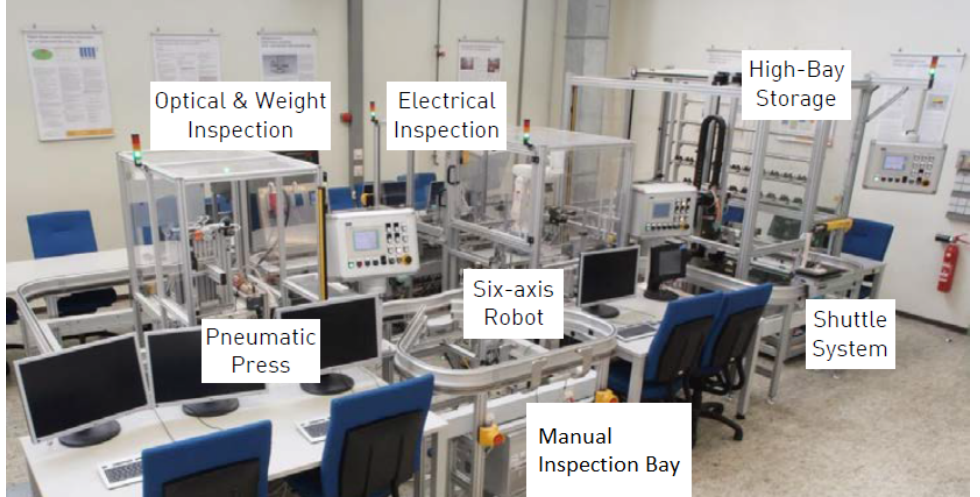
Figure 4. Production-equal smart factory at the DUAS [6]. A monorail shuttle system connects the high-bay storage with a six-axis assembly robot, a press, the optical and weight inspection and the electrical inspection station. Unassembled products will be delivered clockwise via the stations.